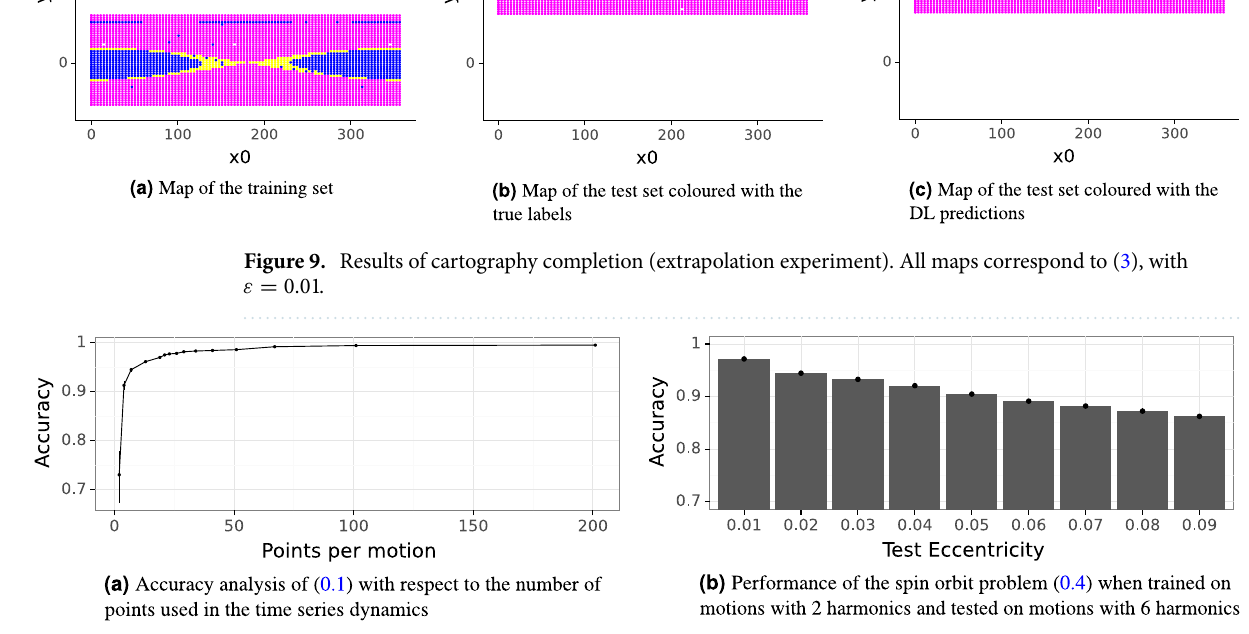
Figure 10. Results of sensitivity to the number of samples and performance in the spin–orbit